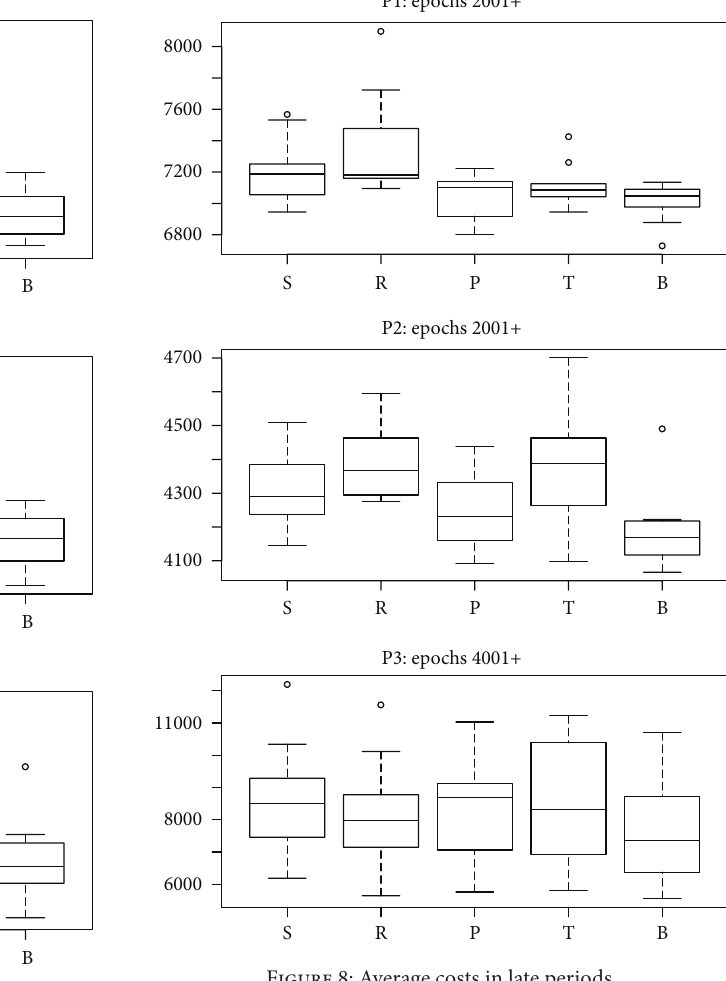
Figure 7: Average costs in early periods.